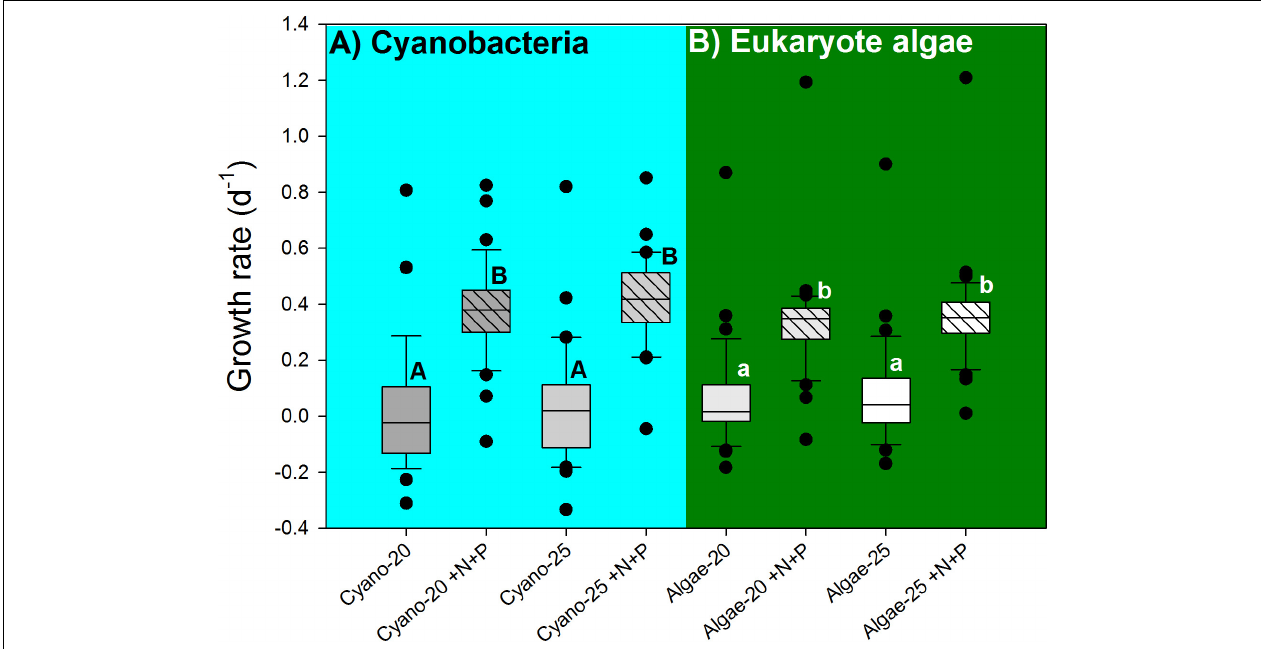
FIGURE 5 | Cyanobacterial growth rates (A) , based on chlorophyll-a concentrations ( µ g l − 1 ) and eukaryote algae growth rates (B) in water samples from 39 urban ponds and lakes incubated for 7 days at 20 ◦ C or 25 ◦ C without extra nutrients or with a pulse of N and P (+N+P). The boxes indicate the 25th – 75th percentiles, the line the median, the whiskers the 10th and 90th percentile and the dots each outlier. Similar letters (A,B for cyanobacteria and a,b for eukaryote algae) indicate homogeneous groups that are not different from each